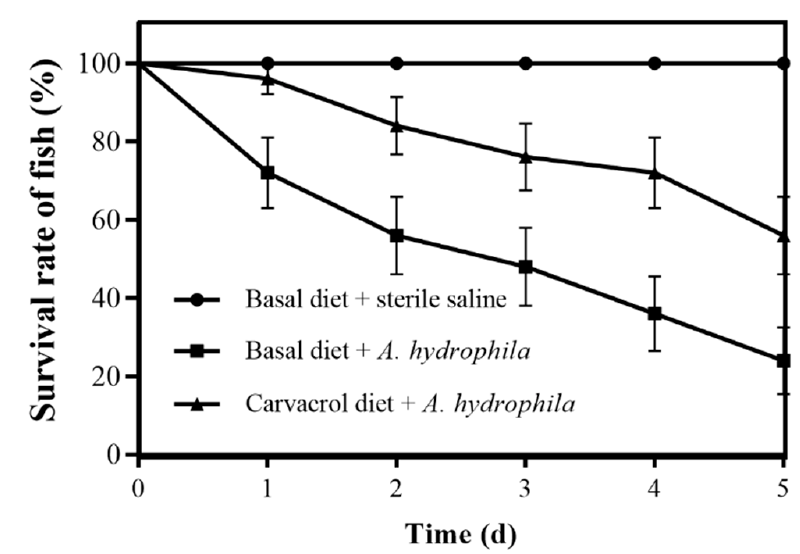
Figure 5. Effect of dietary carvacrol on the survival of grass carp infected with A. hydrophila NJ-35. In the basal diet and carvacrol groups, 25 fish were intraperitoneally injected with A. hydrophila or sterile saline, respectively. Error bars: 95% confidence intervals.